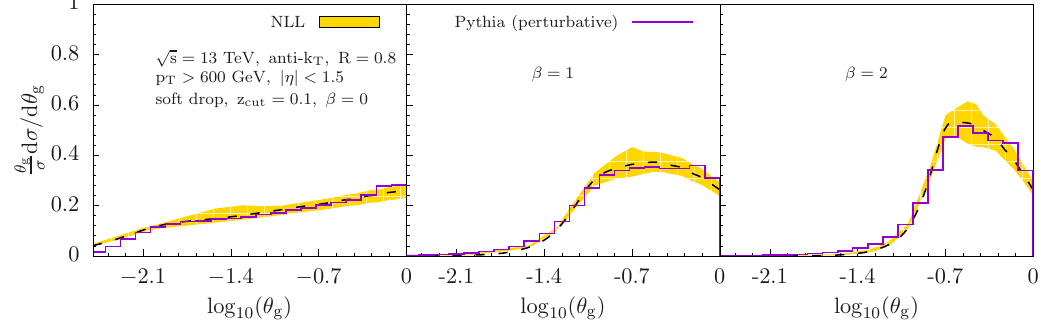
Figure 6 . The normalized soft drop groomed jet radius (cid:18) g at NLL (dashed black, yellow band) in proton-proton collisions at p s = 13 TeV. The jet kinematics are speci(cid:12)ed in the (cid:12)gure. We compare to Pythia 8 simulations [88] (purple) at the parton level, without hadronization and the underlying event contribution, for three di(cid:11)erent values of (cid:12) = 0 ; 1 ; 2 (left to right). corresponding to the theoretical uncertainties obtained by varying all scales up-and-down by factors of 2 around their central values while maintaining the relations